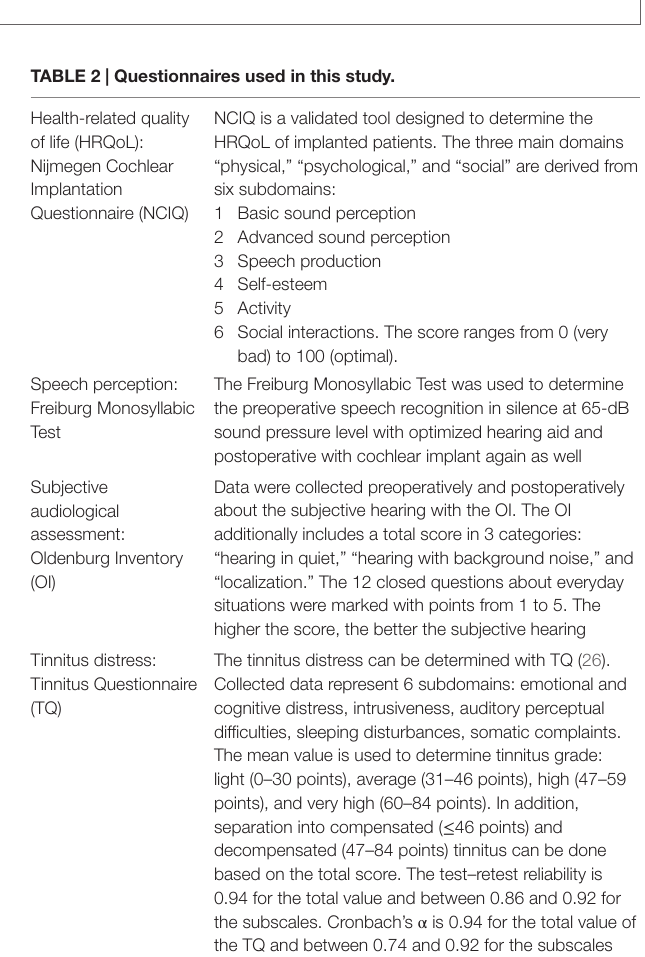
FigUre 1 | study design